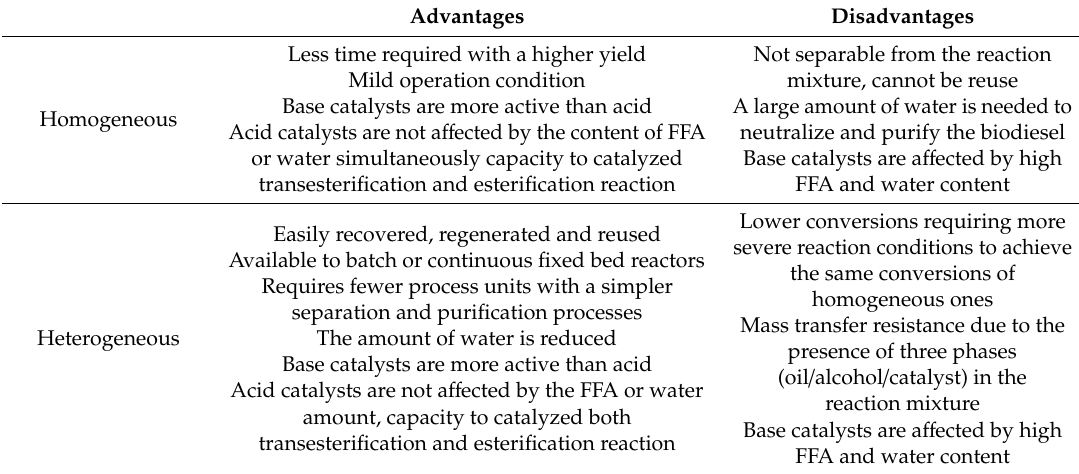
Advantages and disadvantages of homogeneous and heterogeneous catalysts in biodiesel